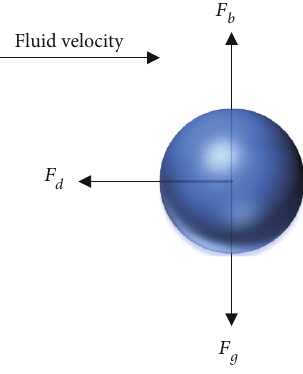
Figure 1: Forces on a particle in fl